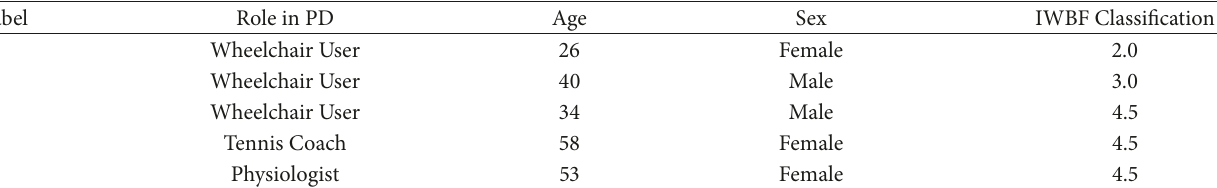
Table 1: Characteristics of the codesigners (participants).